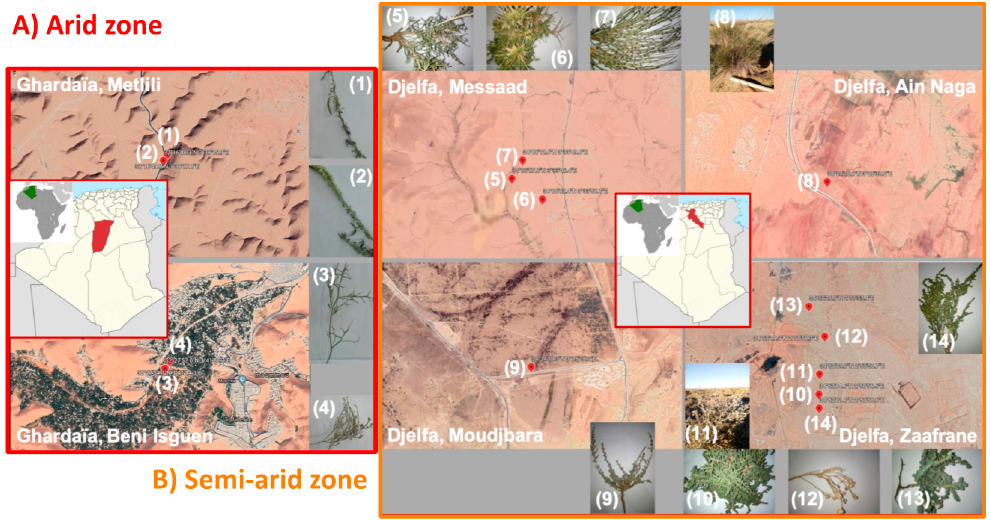
Figure 1. Soil sampling sites. ( A ) Two soil sampling sites in the arid region of Ghardaïa (Algeria): Metlili and Beni Isguen. The sampled soils were associated to the roots of different plants: (1) Cleome arabica , (2) Reseda villosa , (3) Zilla spinosa , (4) Pulicaria undulata . ( B ) Four soil sampling sites in the semi-arid region of Djelfa (Algeria): Messaad, Ain Naga, Moudjbara and Zaafrane. The sampled soils were associated to the roots of different plants: (5) Arthrophytum scoparium , (6) Astragalus armatus , (7) Retama raetam , (8) Stipa tenacissima , (9) Artemisia herba-alba , (10) Salsola tetragona , (11) Atriplex halimus , (12) Peganum harmala , (13) Suaeda fruticose , (14) Thymelaea microphylla . The numeric labels and the pictures of the different plants are shown in the figure.